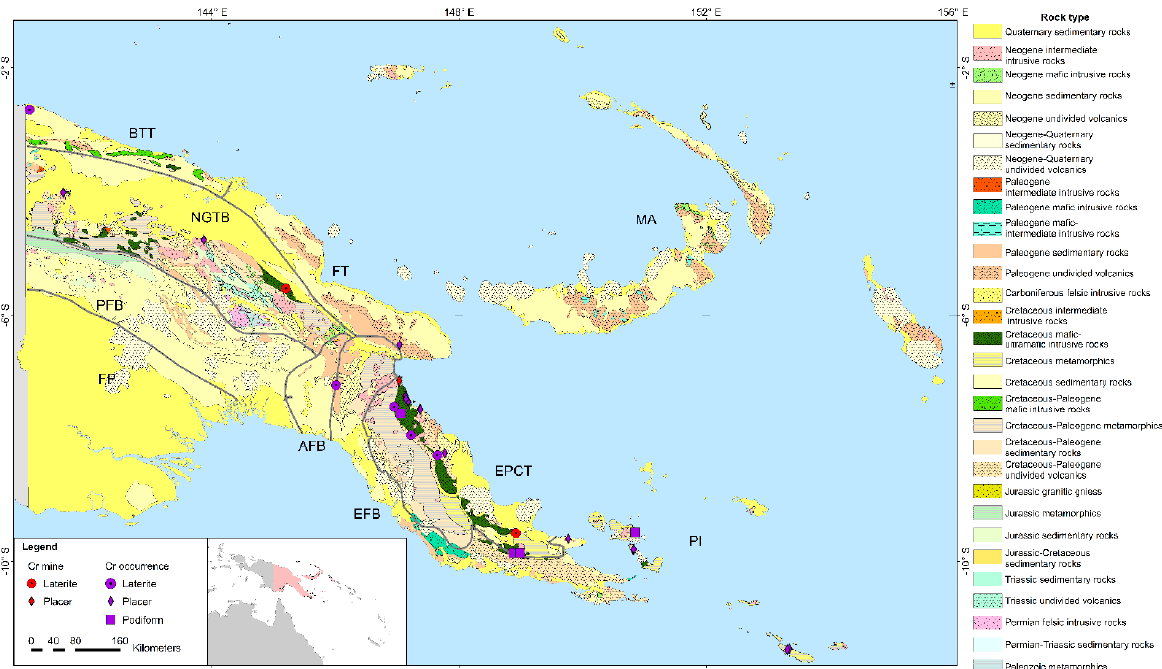
Figure 1. Distribution of chromium ‐ bearing deposits and chromium occurrence (modified from [10,25,26]). FP, Fly Platform; PFB, Papuan Fold Belt; NGTB, New Guinea Thrust Belt; AFB, Aure Fold Belt; EFB, Eastern Fold Belt; EPCT, Eastern Papuan Composite Terrane; FT, Finisterre Terrane; BTT, Bewani–Torricelli Terrane; MA, Melanesian Arc; PI, Papuan Islands. Table 1. Basic information of chromium ‐ bearing mines and chromium occurrence in PNG [25].